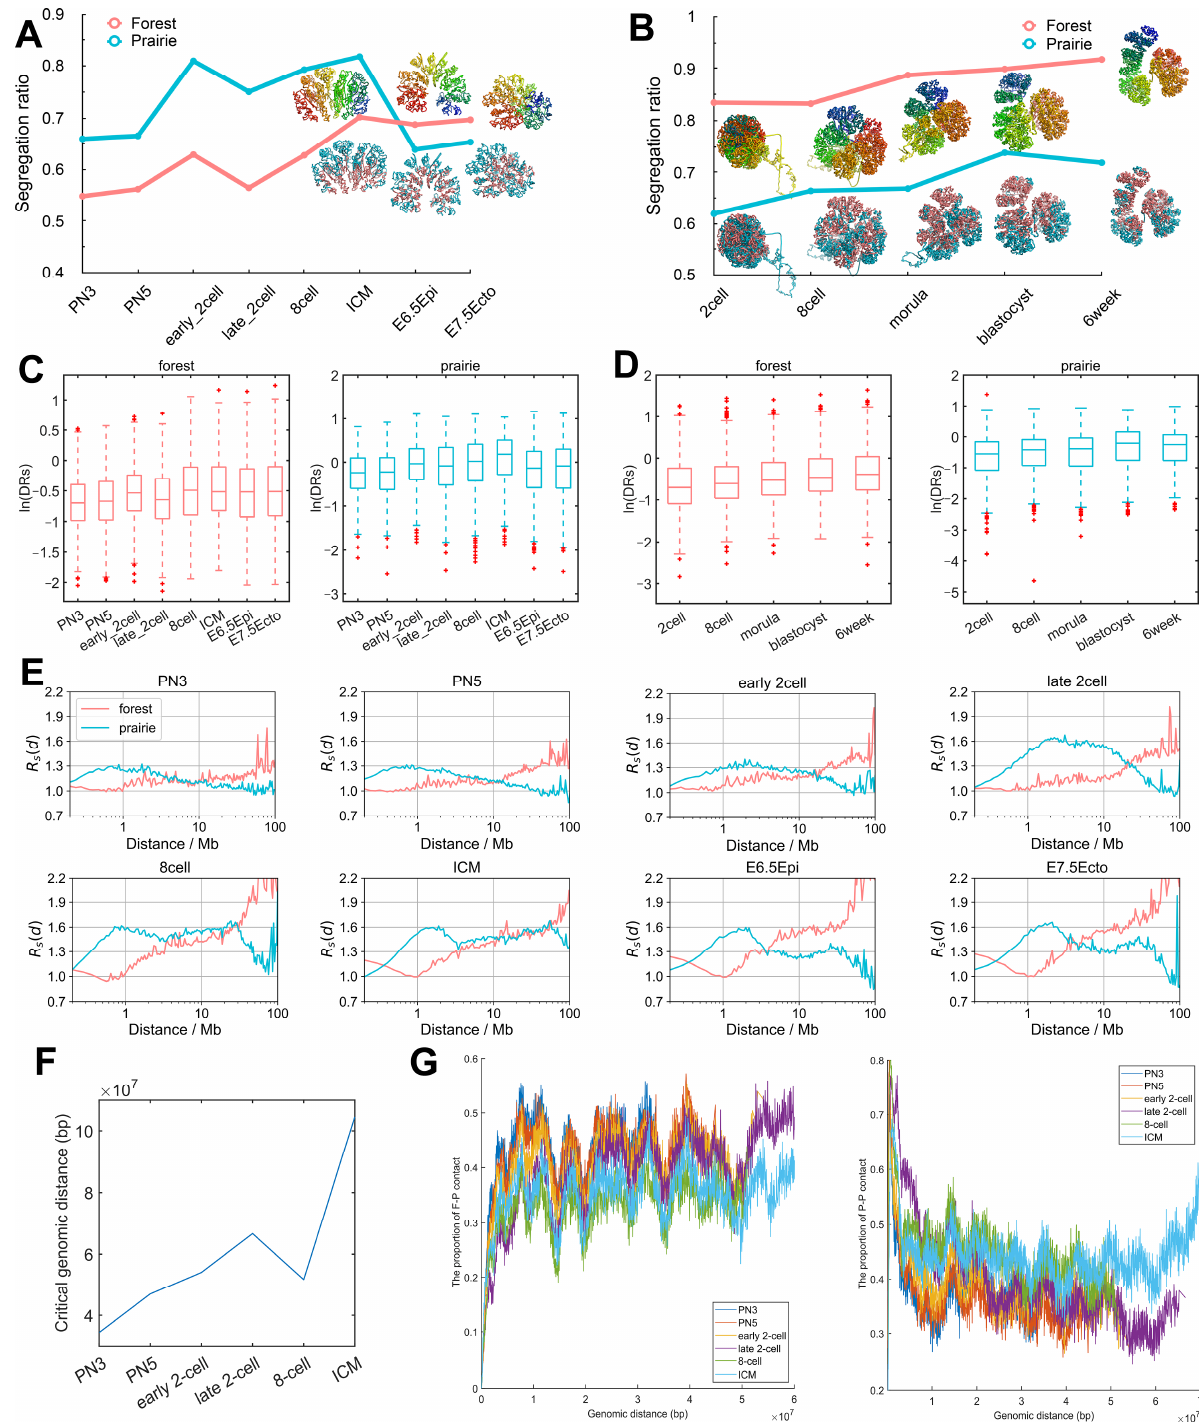
Figure 1. Domain segregation in early embryonic development. ( A , B ) The chromatin overall segregation ratio OR s of forest and prairie domains at each stage in mouse ( A ) and human ( B ) embryonic development. Modeled chromatin structures are also shown at corresponding stages. The upper structures are colored by the sequence from blue to red, and the lower structures are colored by forest/prairie domains. ( C , D ) The domain segregation ratio DR s of forest and prairie domains at each stage in mouse ( C ) and human ( D ) embryonic development. ( E ) The distance-dependent segregation ratio R s ( d ) of forest and prairie at each stage in mouse embryonic development. ( F ) The change of critical genomic distance during mouse embryonic development. ( G ) The proportions of F–P and P–P spatial interactions within the top 10% contact probabilities under one certain genomic distance, at each stage in mouse embryonic